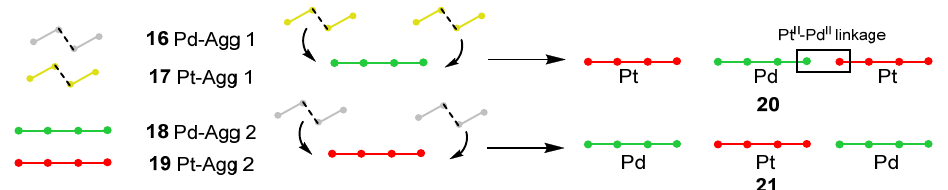
Figure 8. Schematic representation of the preparation of multi-block Pt(II) and Pd(II) supramolecular copolymers using a living supramolecular polymerization approach. Adapted from [67].